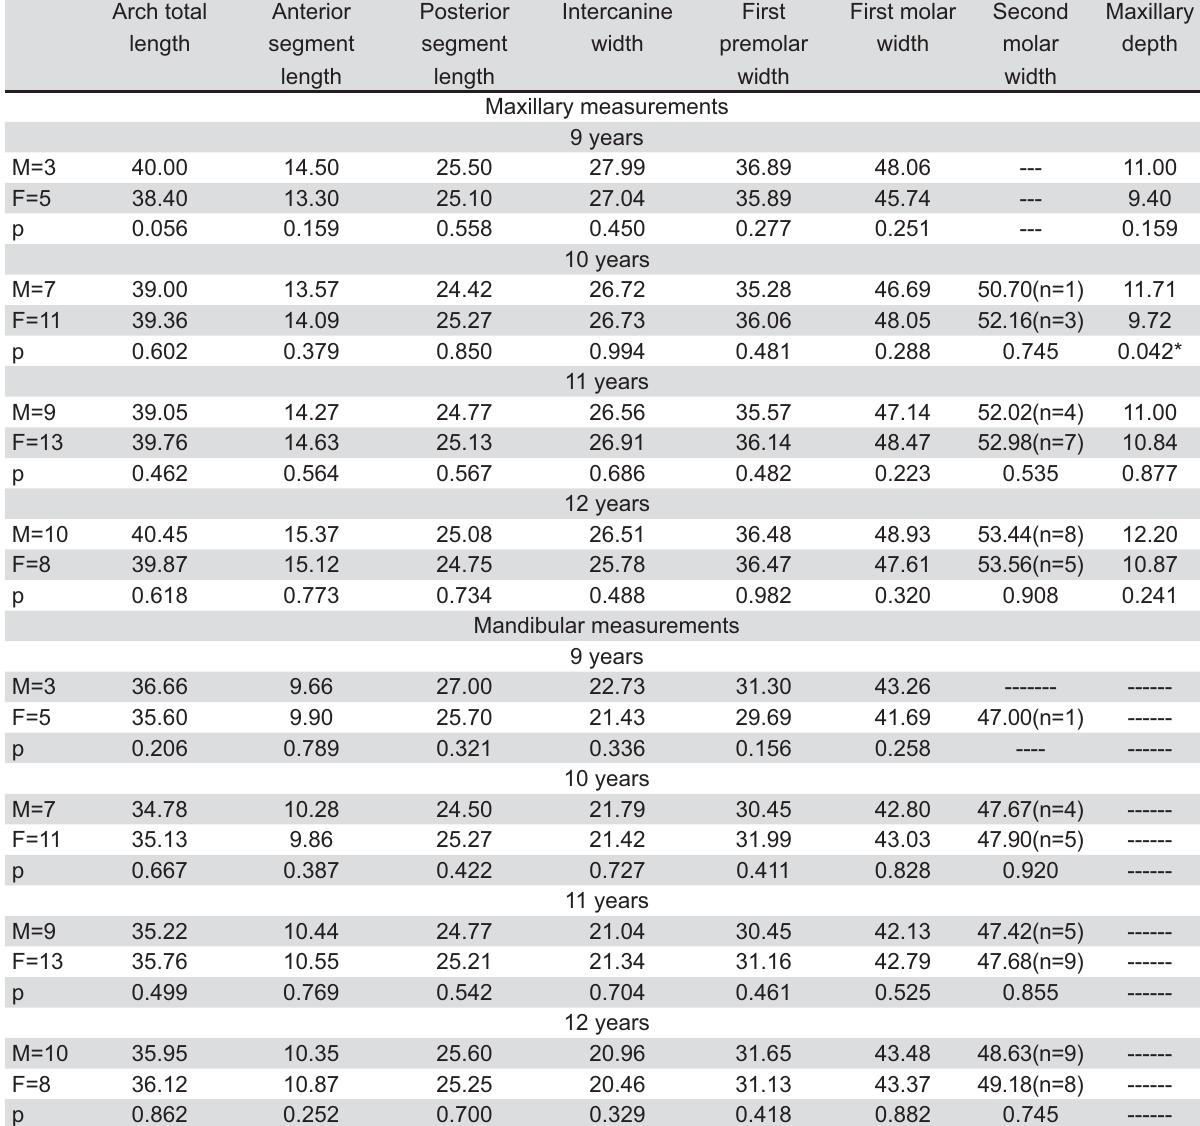
Table 2- Descriptive statistics and comparisons of the males and females in each age-group (according to independent samples t-test P<0.05)